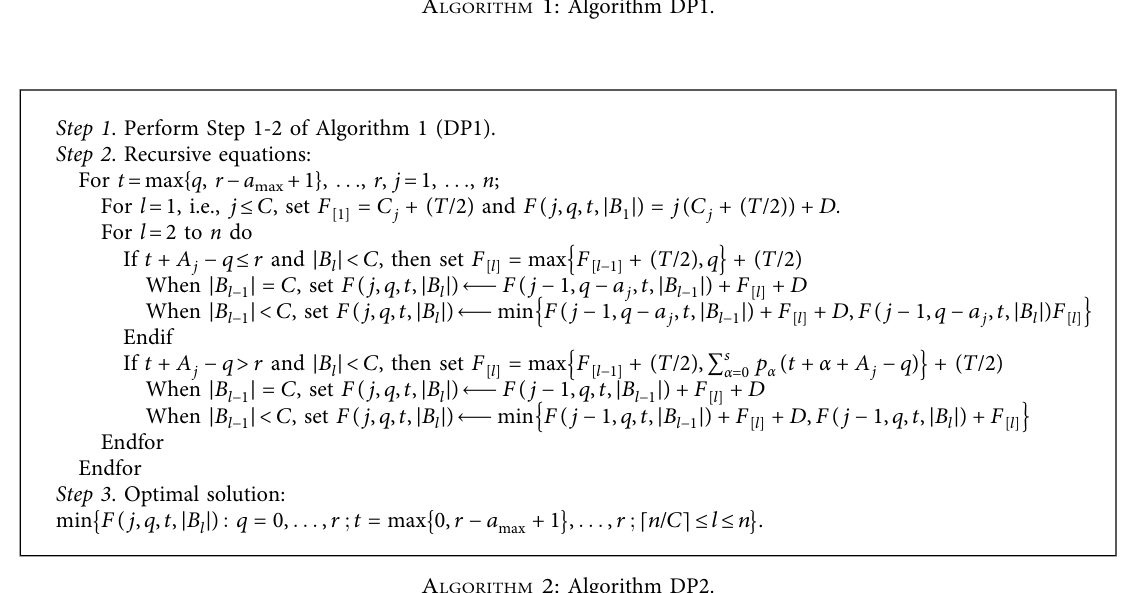
A LGORITHM 2: Algorithm